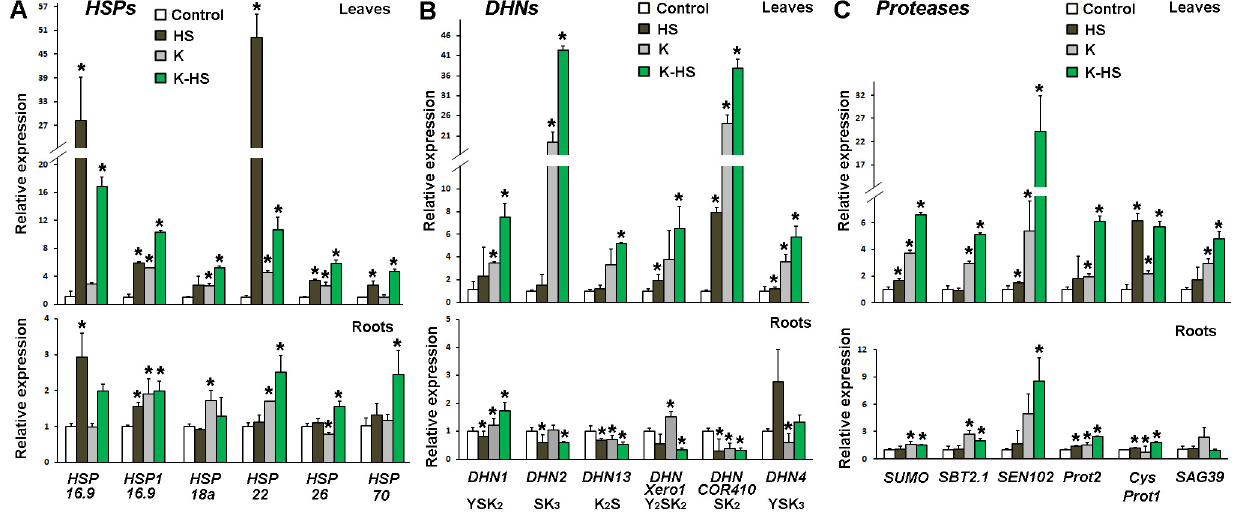
Figure 7. Transcript profiling of genes coding for heat shock proteins (HSPs) ( A ), dehydrins (DHNs) ( B ), and proteases ( C ) in leaves and roots of control and heat-stressed plants (HS) which were not treated with biostimulant; plants which received Kaishi (10 − 12 ) and were grown under normal conditions (K) or subjected to heat shock 24 h later (K-HS). Values are means of three biological repeats ( n = 3) ± SD, and the asterisks designate statistical significance compared to the control sample at p < 0.05, (one-way ANOVA).